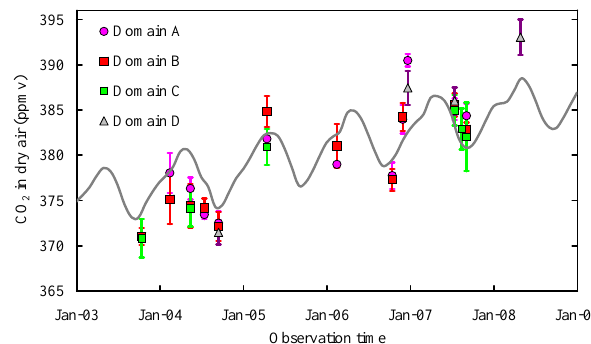
Fig. 5. Time series of field-measured atmospheric CO 2 concentra- tions at 10m (mean ± standard deviation in dry air) during the pe- riod from October 2003 to April 2008. A monthly mean data set for the Mauna Loa station (NOAA/ESRL, www.esrl.noaa.gov/gmd/ ccgg/trends/) is also plotted as a grey